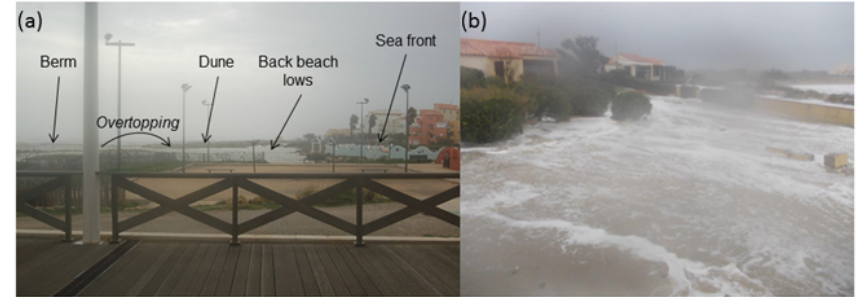
Figure 9. Overtopping observed during the March 2013 event at zone C (a) and zone B (b) sea